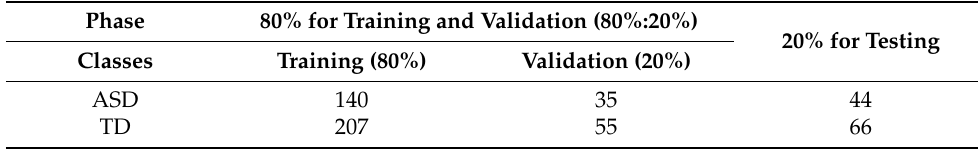
Table 3. Splitting the ASD dataset for training and